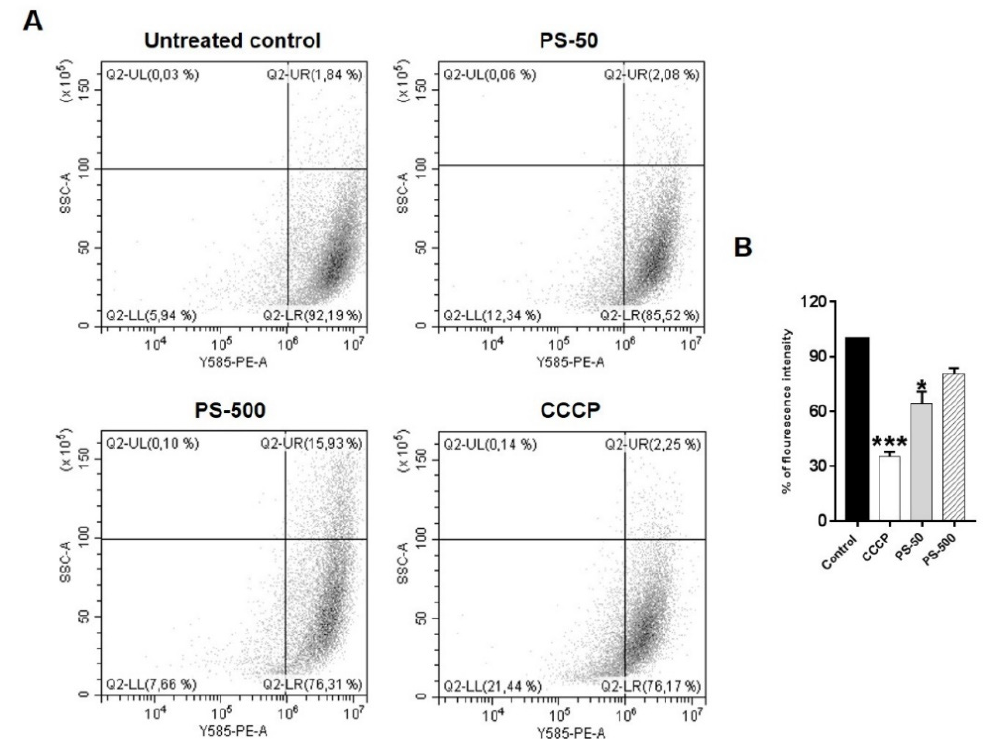
Figure 5. The dot plots and graph indicate the loss of mitochondrial membrane potential due to PSNPL exposure in HNEpCs after 24 h of treatments. ( A ) The dot plots represented the decrease in fluorescence intensity as an indicator of loss of MMP due to treatment of HNEpCs with PSNPLs (far left quadrant) over the untreated control. CCCP acted as a positive control. ( B ) The graph represents the significant loss of MMP due to PS-50 in the treated cells vs. untreated control cells. * p ≤ 0.05, *** p ≤ 0.001.